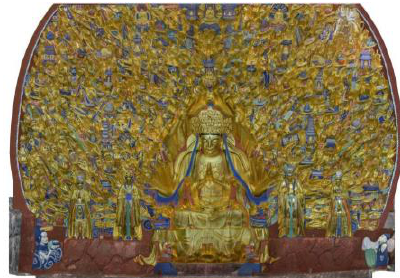
Figure 9. The Effect of Virtual